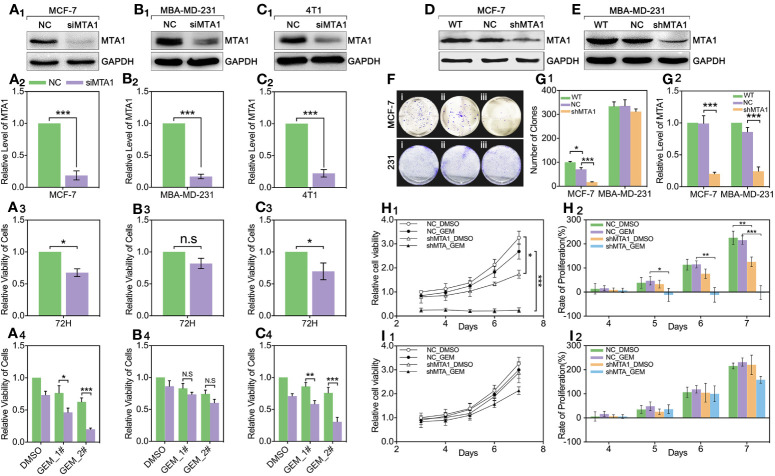
Down regulation of MTA1 sensitized gemcitabine-induced tumor growth regression in MCF-7 cell lines. (1) WB and statistics for small interfere RNA (siRNA) induced MTA1 knockdown in breast cancer cell lines: MCF-6, MBA-MD-231 and 4T1 (A1-2–C1-2). (2) viability of cells, tested by MTT after 48h-treatment of siRNA and 72h culturing in 96-wells plates (A3–C3). (3) cells are treated with siRNA for 48h followed by 48h-treatment of DMSO, 5μM gemcitabine or 10μM of gemcitabine (A4–C4). (4) Stable knockdown of MTA1 in MCF-7 and MBA-MD-231 cells, verified by WB (D, E, G2). (5) Cloning formation of WT_ MCF-7/MBA-MD-231(i), NC_ MCF-7/MBA-MD-231(ii) and shMTA1_MCF-7/MBA-MD-231(iii) cells (F, G1). (6) NC_ MCF-7 and shMTA1_MCF-7 are treated with gemcitabine or DMSO for 48h, and then are cultured in fresh complete medium for 5 days, in which cells are tested for viability through MTT every day, and cell growth was inhibited as compared with NC (H1, H2). (7) NC_MBA-MD-231 and siMTA_MBA-MD-231 cells are treated with gemcitabine or DMSO for 48h, and then are cultured in fresh complete medium for 5 days, which cells are tested for viability through MTT every day, and cell growth was inhibited as compared with NC (I1, I2).